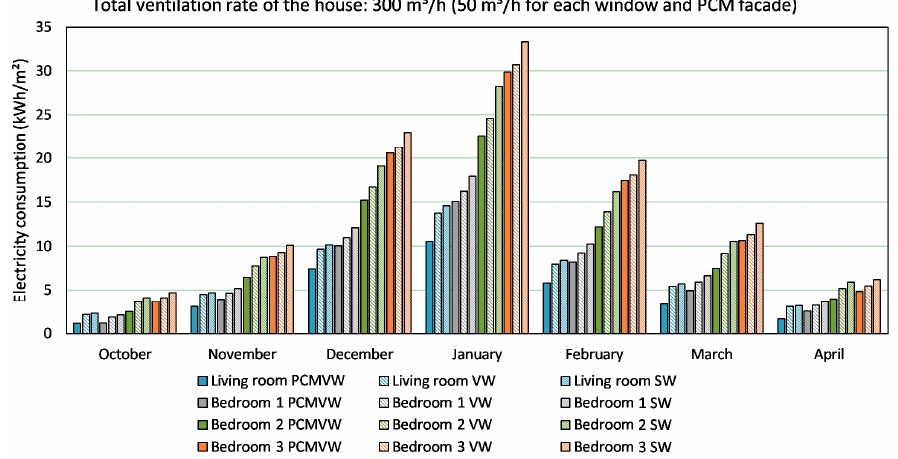
Figure 20. The electricity consumption of each room during the winter period at a ventilation airflow rate of 300 m 3 /h.